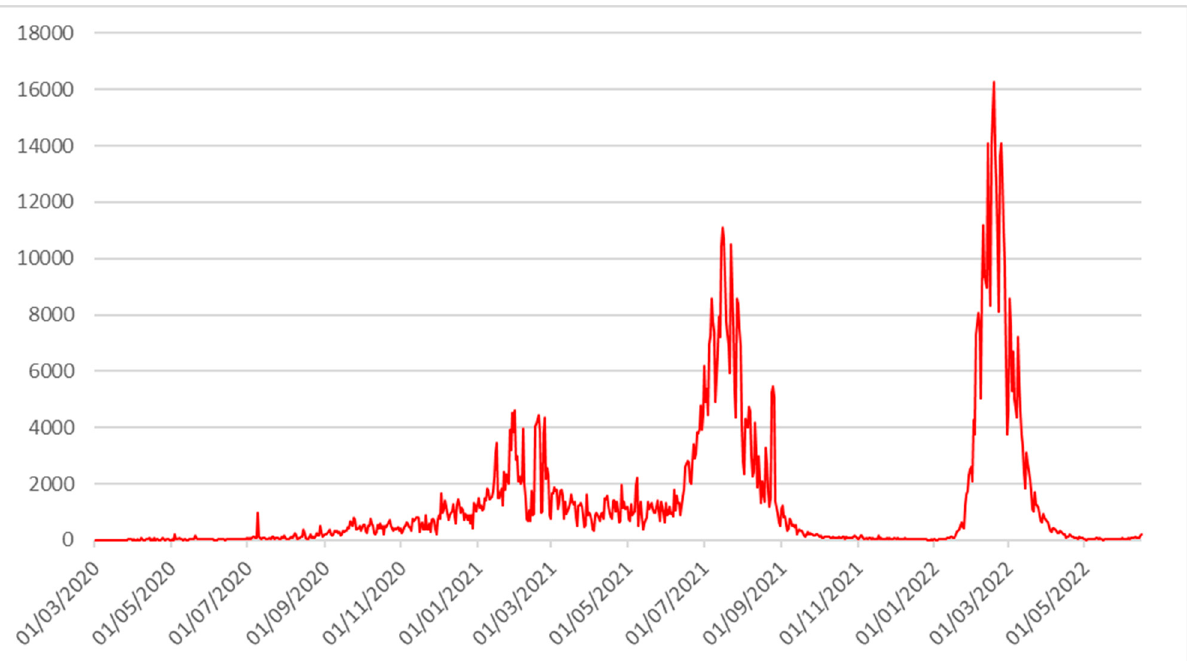
Figure 1. Daily positive cases of COVID-19 in West Java.